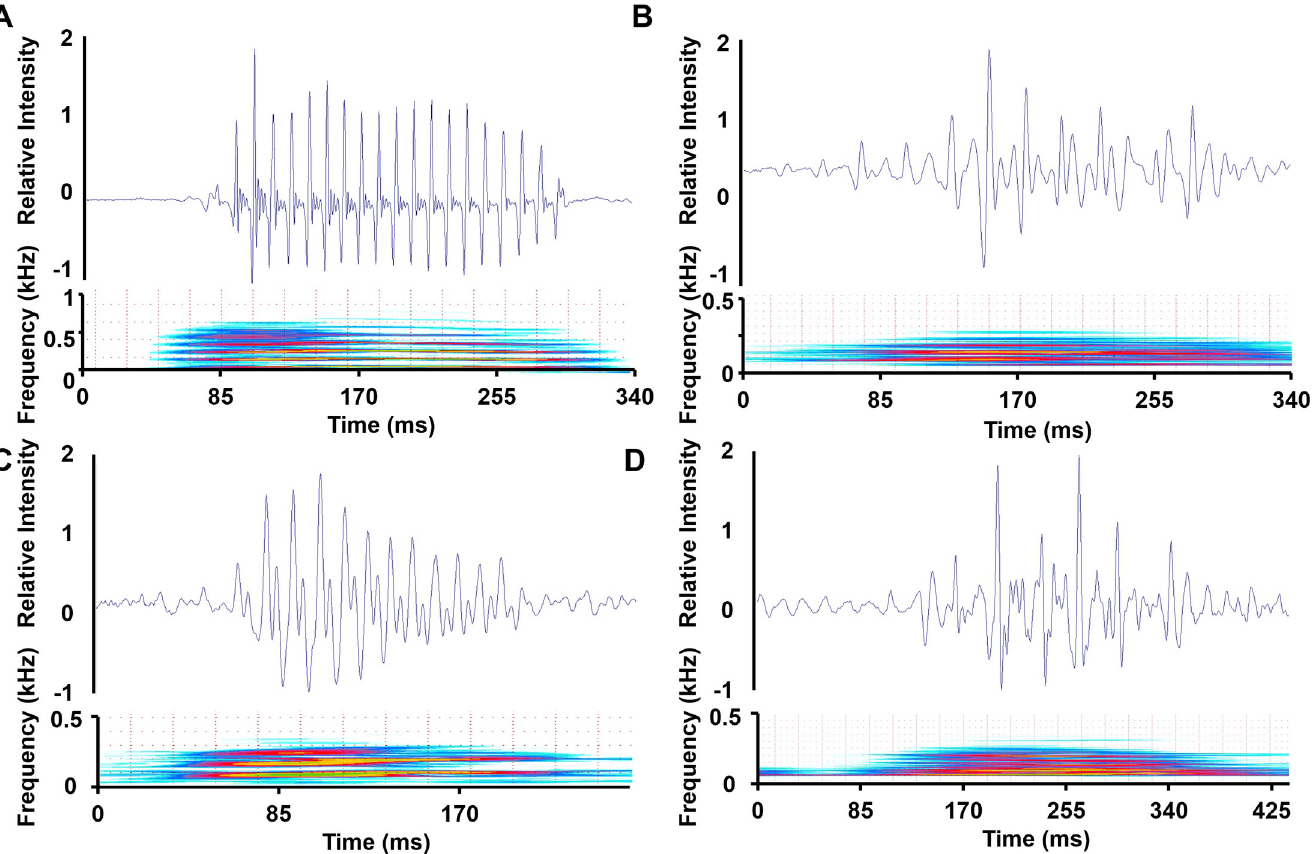
Fig 3. Waveform (top) and spectrogram (bottom) of a sound produced by A. Pygocentrus cariba , B. Pygocentrus piraya . C. red-bellied Pygocentrus nattereri and D. yellow-bellied Pygocentrus nattereri . FFT Length: 512, window: Hamming, frame: 100%.